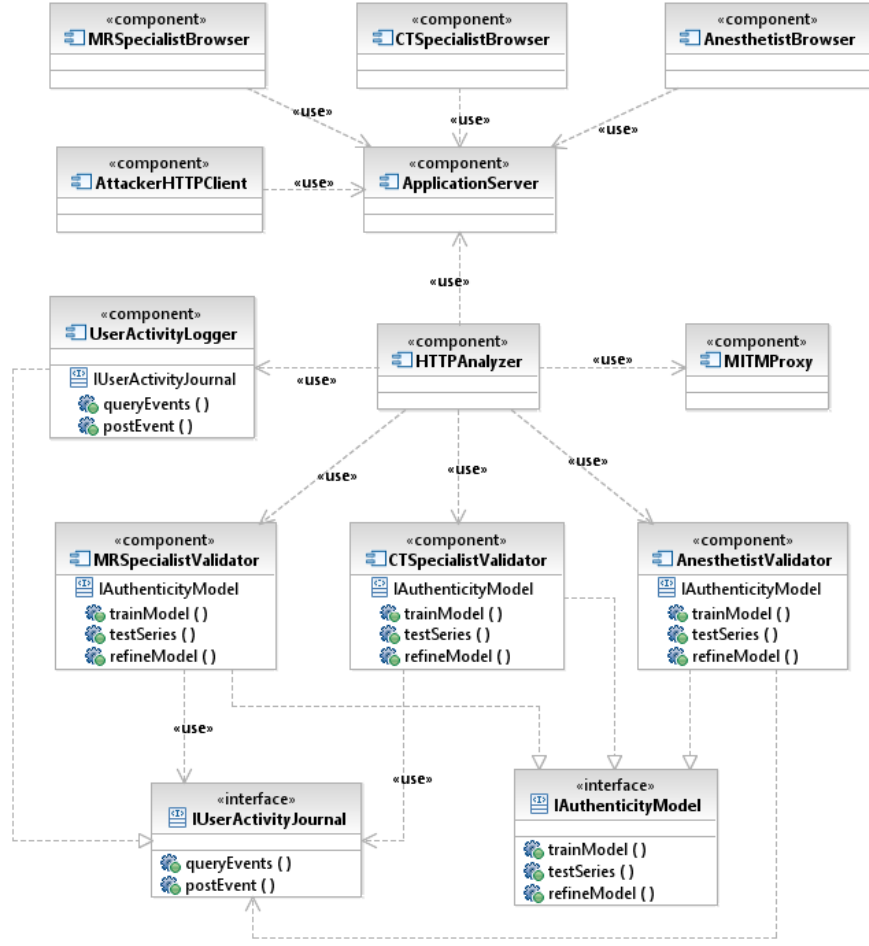
Figure 6. Component diagram of the subsystem for analysis of users’